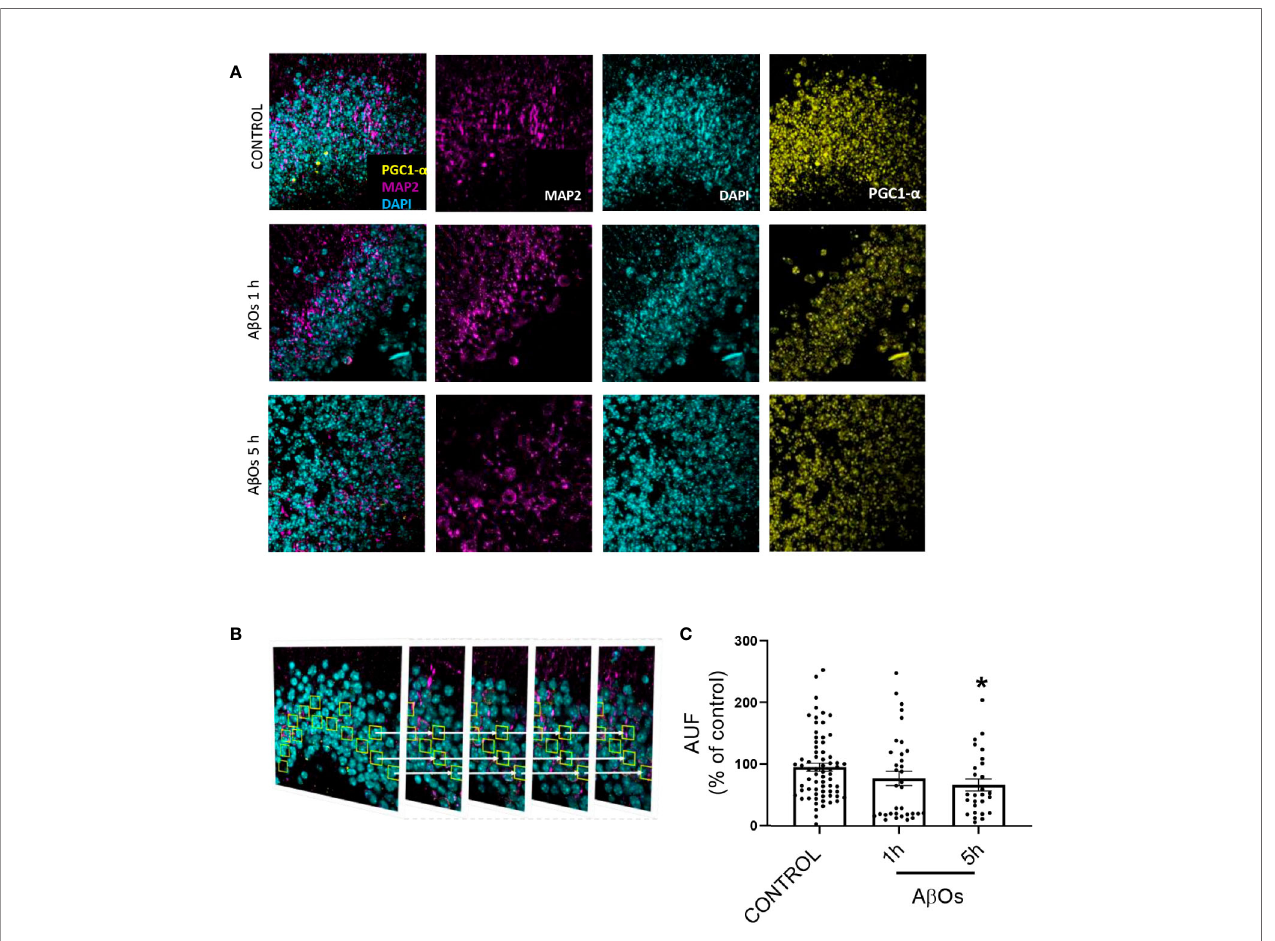
FIGURE 11 | Immunohistochemistry of PGC-1 a after acute and sub-chronic treatments of A b Os in mice hippocampal slices. (A) Maximum intensity projections of confocal images showing neurons from the granular layer of the dentate gyrus in mice hippocampus stained for: PGC-1 a (yellow), MAP2 (violet, for neurons), and DAPI (cyan, for nucleus). (B) Maximum intensity projections of stacked confocal images showed in (A) . (C) Normalized quanti fi cation of the fl uorescence intensity for PGC-1 a normalized with respect to MAP2 immuno fl uorescence in control condition and after A b Os (0.5 m M) exposure for 1 or 5 h. Scale bars: 5 m m. Data analyzed using one way ANOVA with Kruskall-Wallis test and Dunn's Multiple Comparison test. (*p < 0.05 vs control nroi: 462/nslices: 75, A b Os 1H nroi: 664/nslices: 37, A b Os 5H nroi: 977/nslices: 30/per each independent experiment,